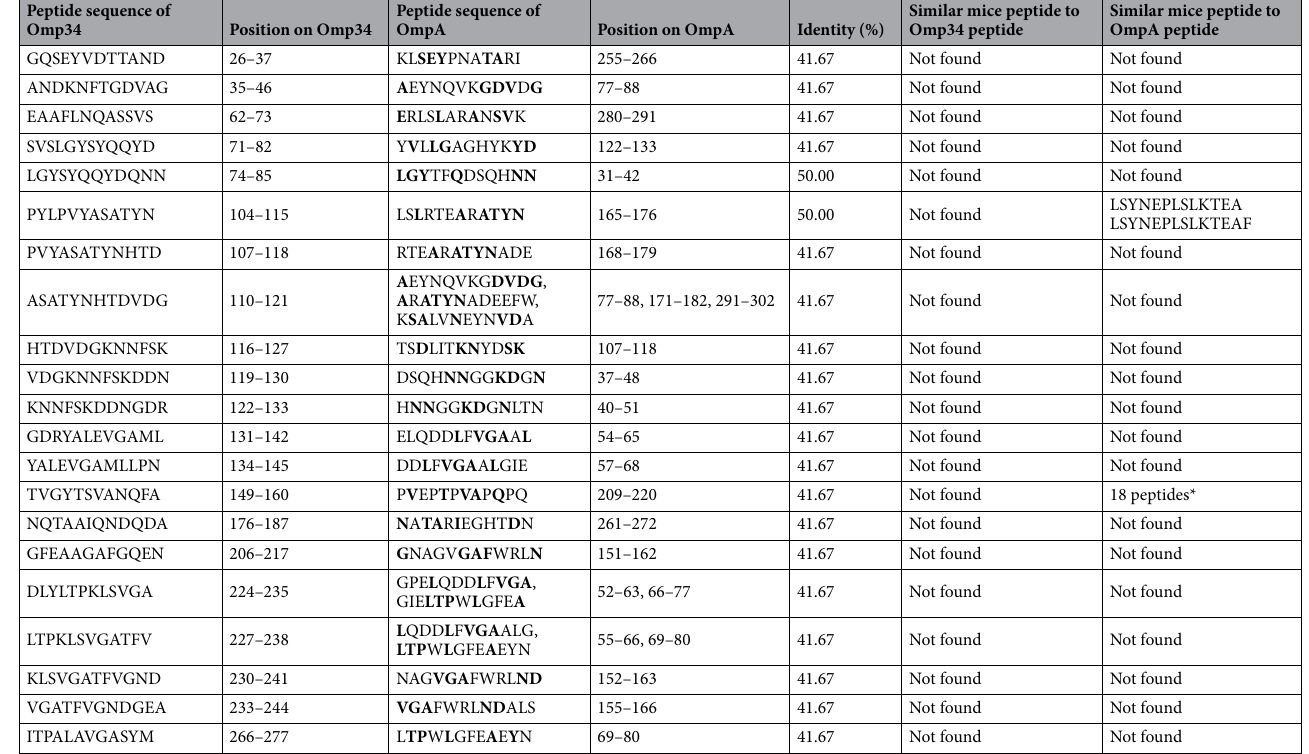
Table 1. Similar peptides of Omp34and OmpA. Bold letters of OmpA peptides are identical residues of OmpA and Omp34 peptides. Peptides of Omp34and OmpA shared similarity with linear epitopes of Mus musculus are shown separately. The bold amino acid letters are identical in OmpA and Omp34 sequences. *SPTPVAPHPVTVPT, TPVAPHPVTVPT,